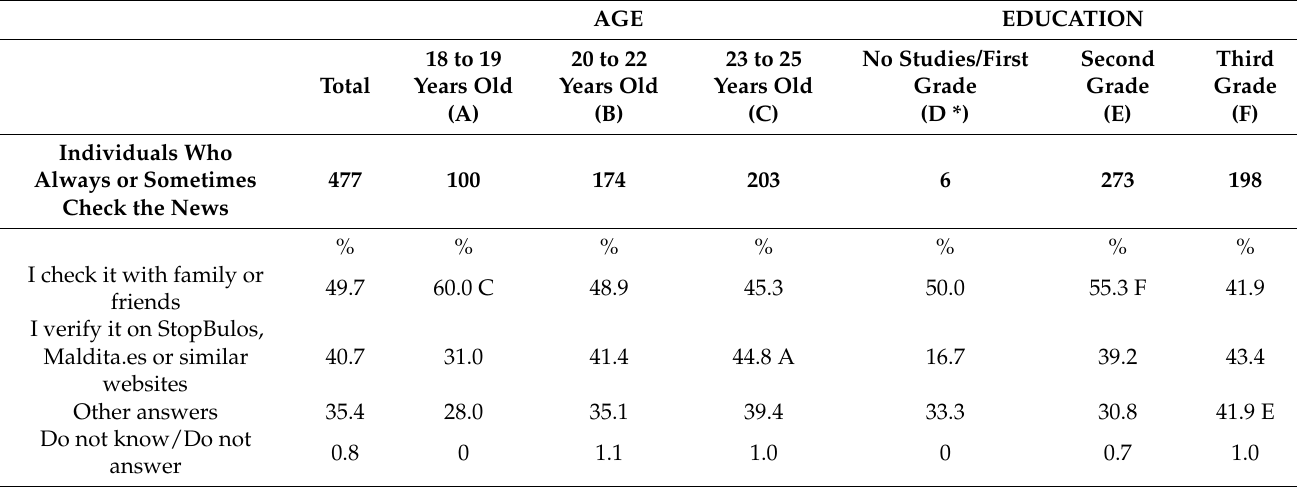
Table 12. Question 7: (Complete if you answer “Always” or “Sometimes” on p. 6) How do you verify whether the information you have searched for or have been sent is true? You can mark multiple answers (Show list with all items).